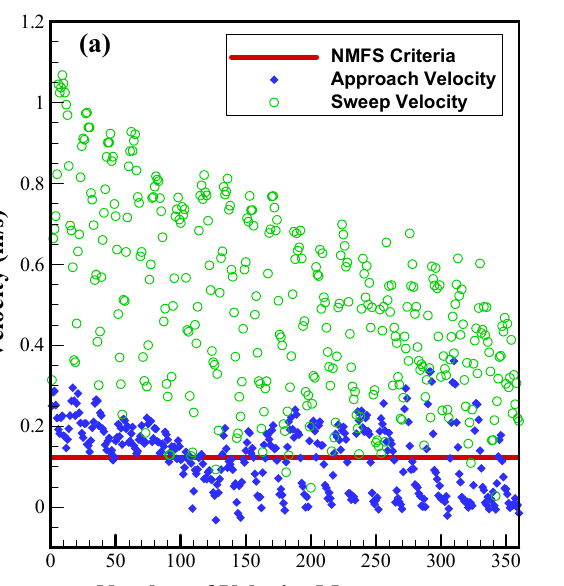
Figure 5. Velocity measurements across an area 0.2 m from the face of the VBS at unit 14A, at a turbine unit discharge rate of 340 m 3 /s. ( a ) B2CC open; ( b ) B2CC closed.